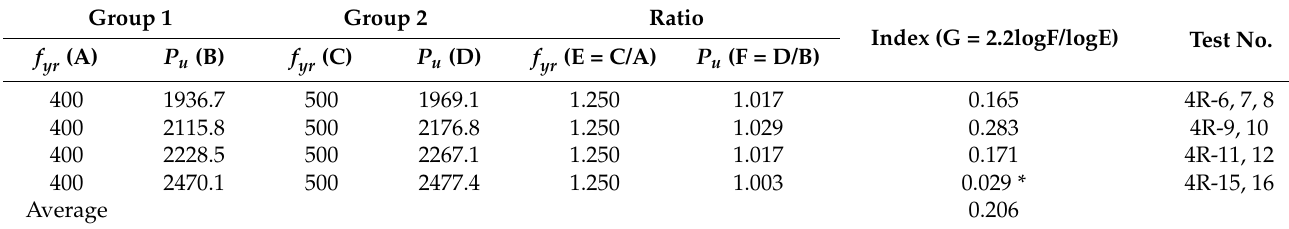
Table 9. Index value for the variable of f yr .